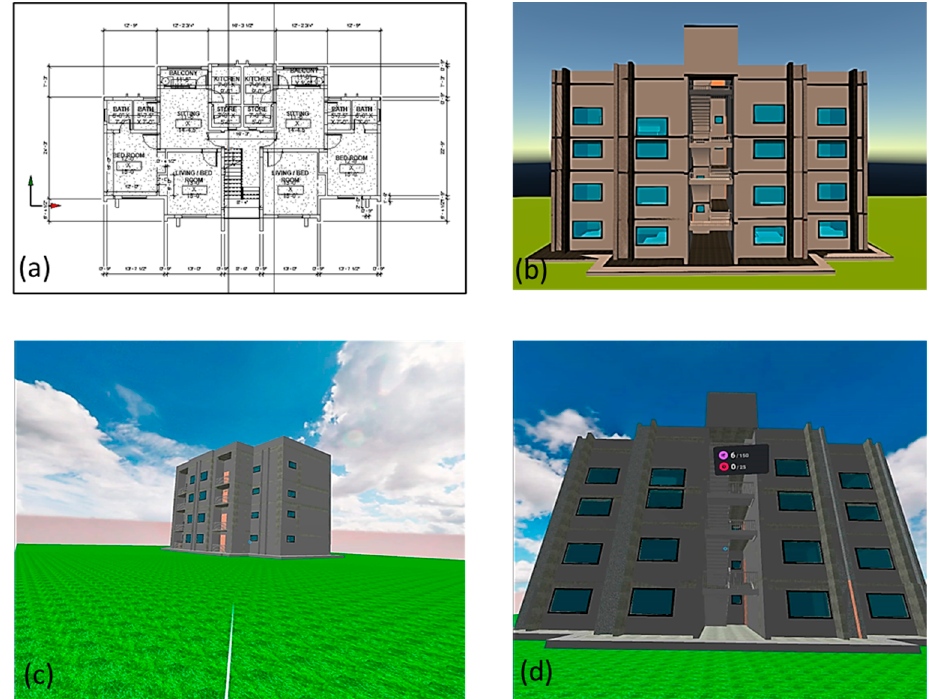
Figure 5. ( a ) paper-based drawing, ( b ) non-immersive monitor-based drawings, ( c , d ) Oculus Quest 2 based IVR